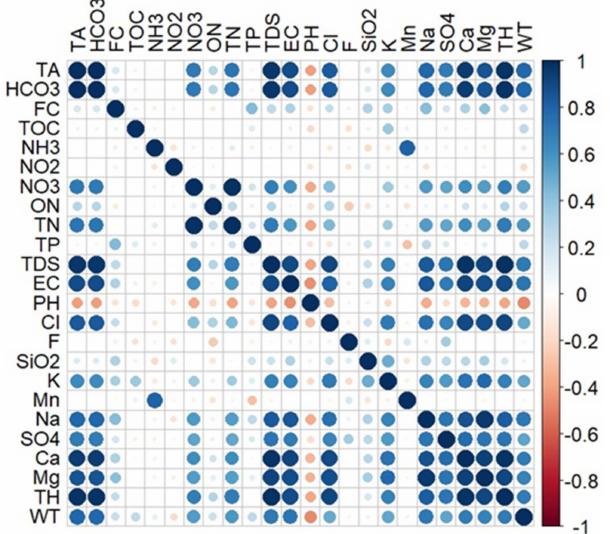
Figure 8. Pearson correlation coefficients of the water quality parameters of the Cuernavaca